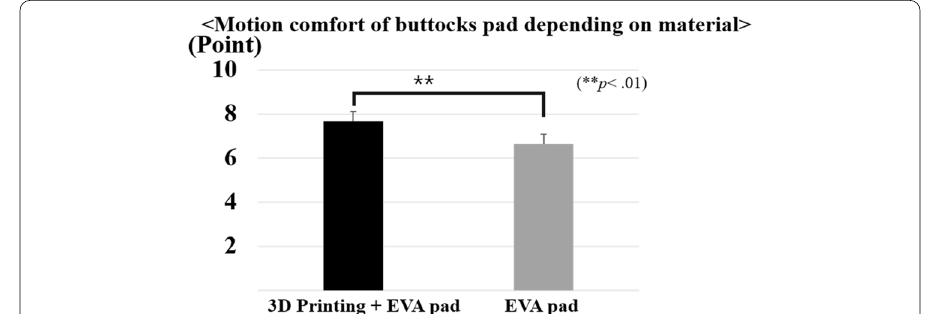
Fig. 14 Subjective motion comfort of buttocks pad depending on material (Bonferroni post hoc analysis method)